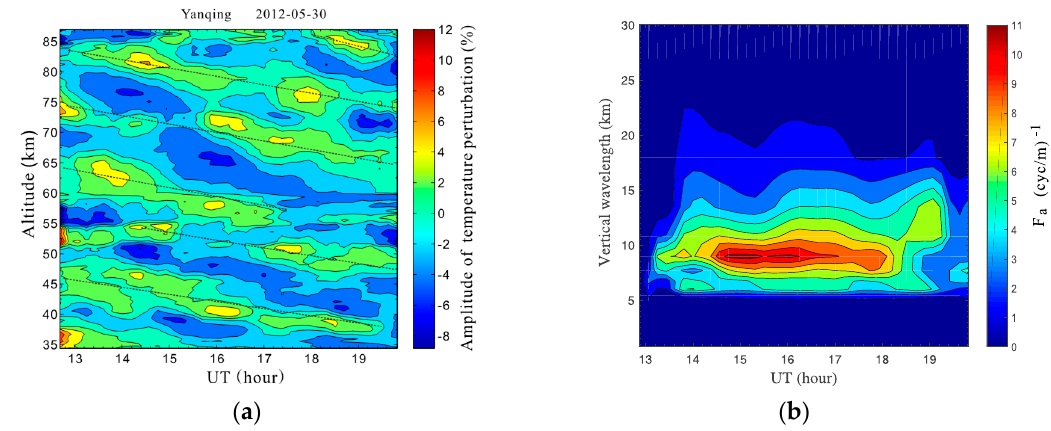
Figure 3. ( a ) Lidar-observed relative temperature perturbation at nighttime on 30 May 2012. The black dotted lines were plotted manually to show the coherent temperature perturbation structures. ( b ) Corresponding vertical wavenumber power spectra for the temperature perturbations associated with gravity waves.